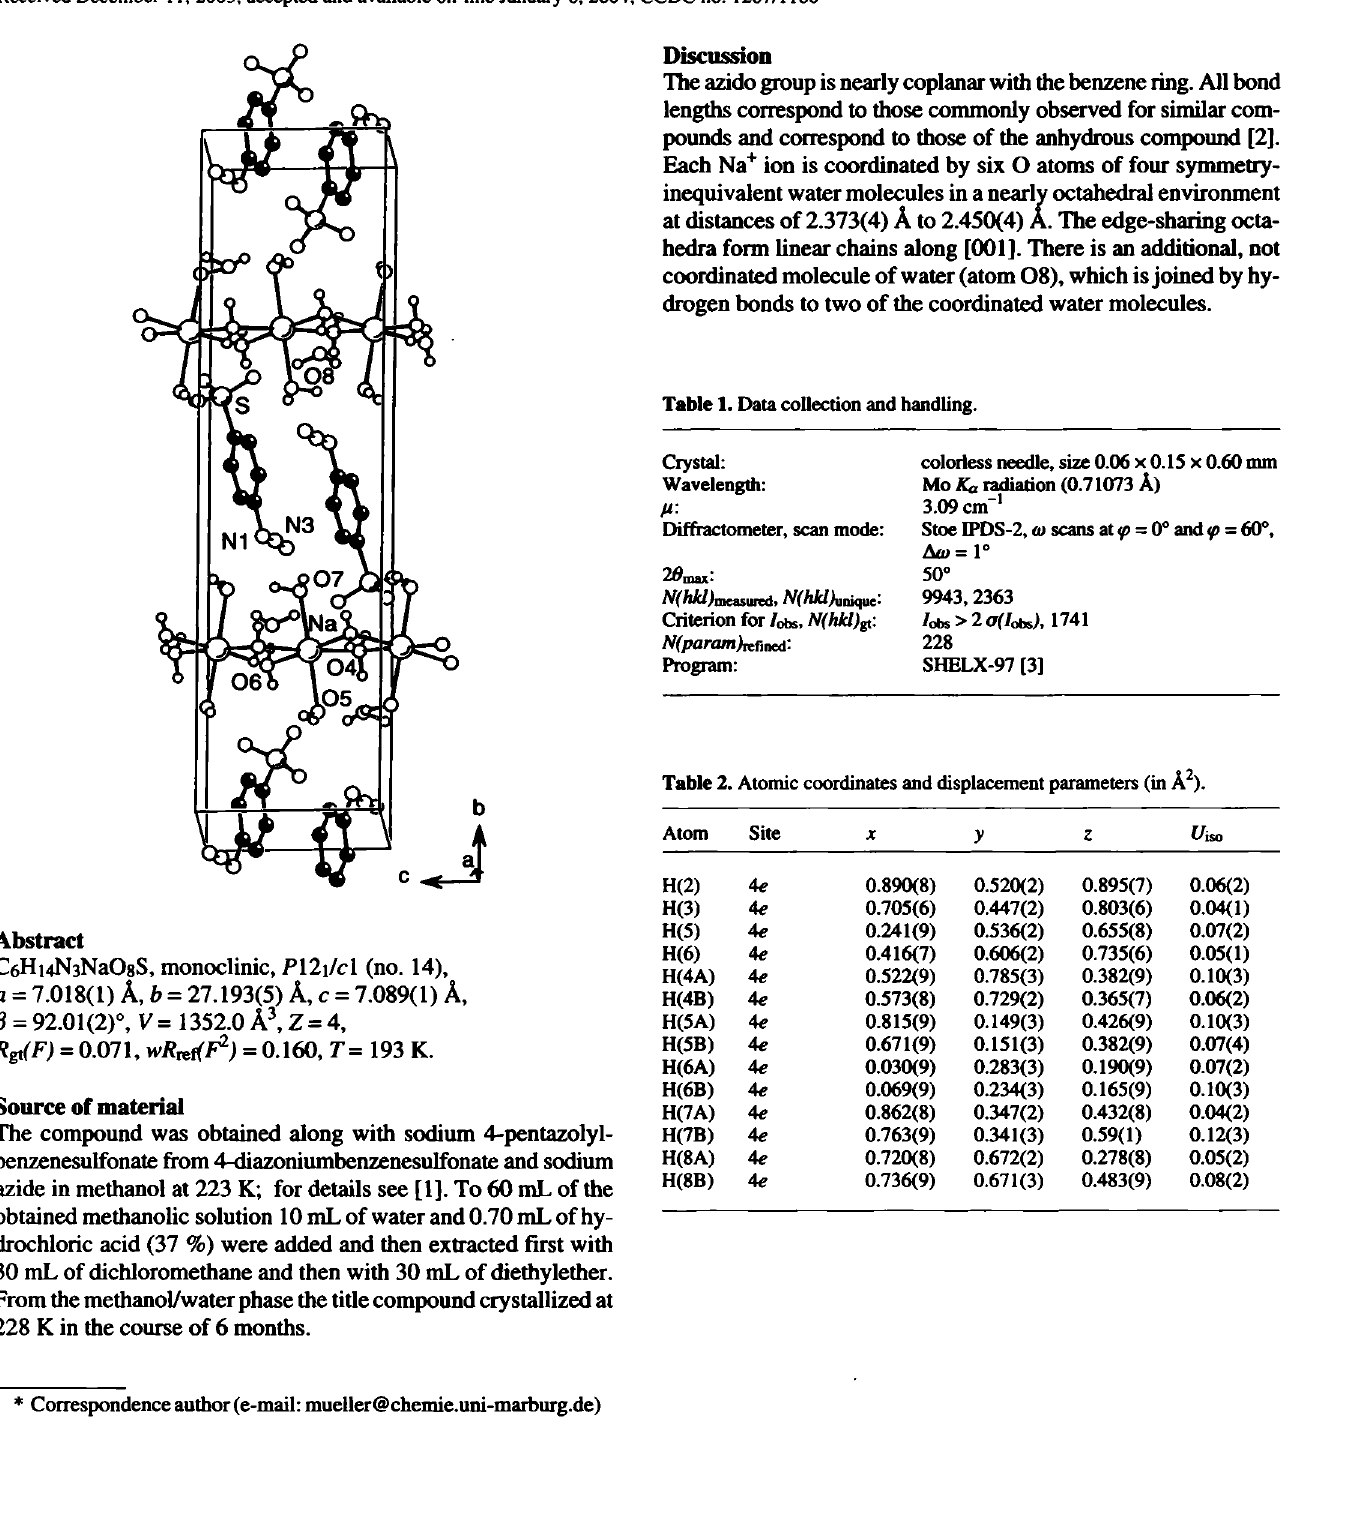
Table 1. Data collection and handling.